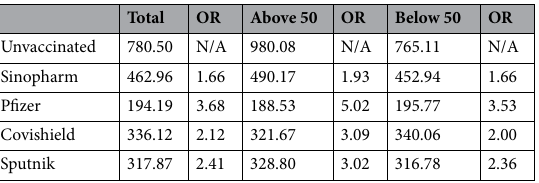
Table 1. Infection rates by vaccine (events per 100 k per week). *In pairwise comparison to unvaccinated, all p values < 0.001.